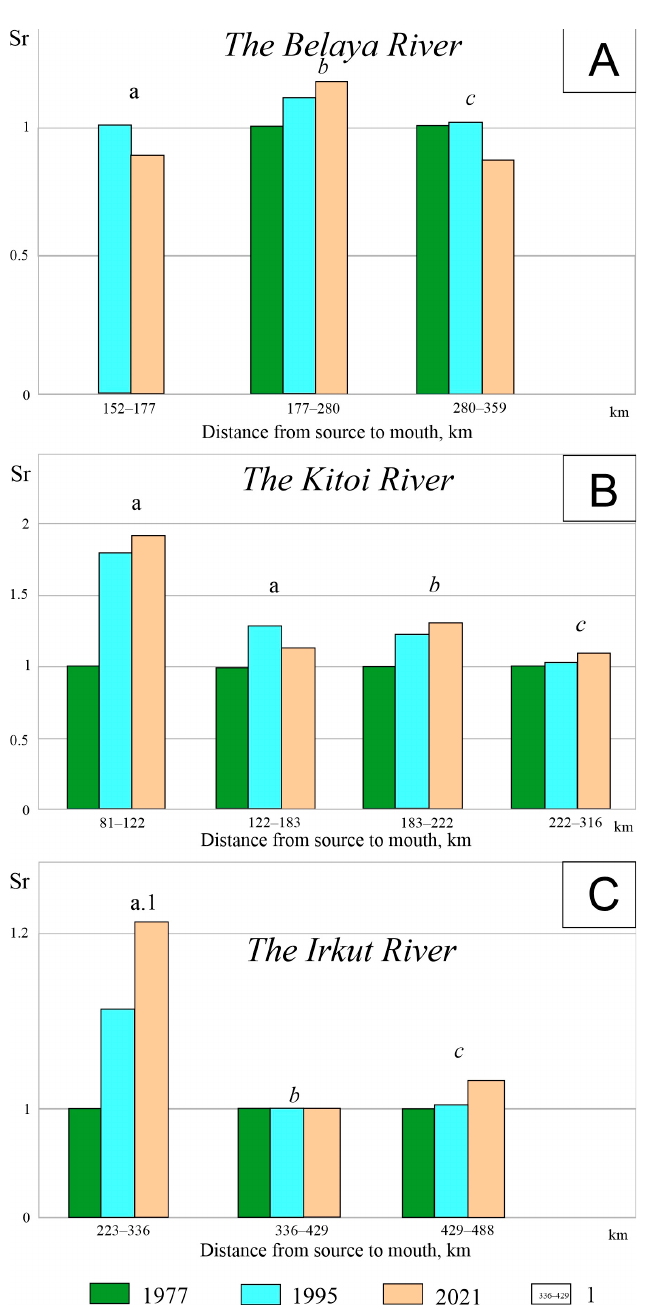
Figure 4. Diagram of changes in the area of the floodplain islands between 1977 and 2021. Dynamics of the area of the floodplain islands of the left-bank tributaries of the Angara River between 1977 and 2021 in various geodynamic areas (periods: 1977—medium water; 1995—relatively high water and 2021—high water ( A )—The Belaya river; ( B )—The Kitoy river; ( C )—The Irkut river). Areas (Sr) are given in relative units (the floodplain area in 1977 is taken as 1); 1–distance from the riverhead. A significant increase (almost twice as large) in the floodplain area occurred in the mountainous part of the KitoiRiver (Figure 4C) within the channel sections with signifi- cant slopes of 5–12‰. Downstream, in the braided reach, the area changes wereinsignifi- cant, increasing with the growth of islands in a relatively dry period and decreasing due to the reduction in the area of islands during flooding in a high-water period. The semi-